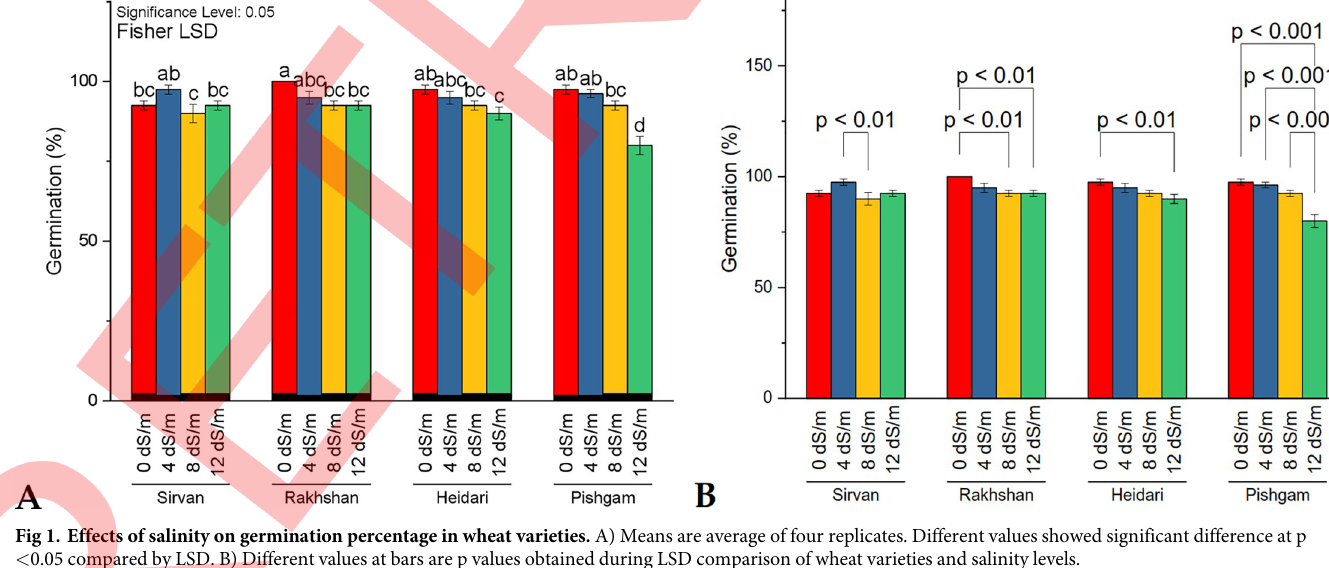
PLOS ONE | https://doi.org/10.1371/journal.pone.0258703 November4,